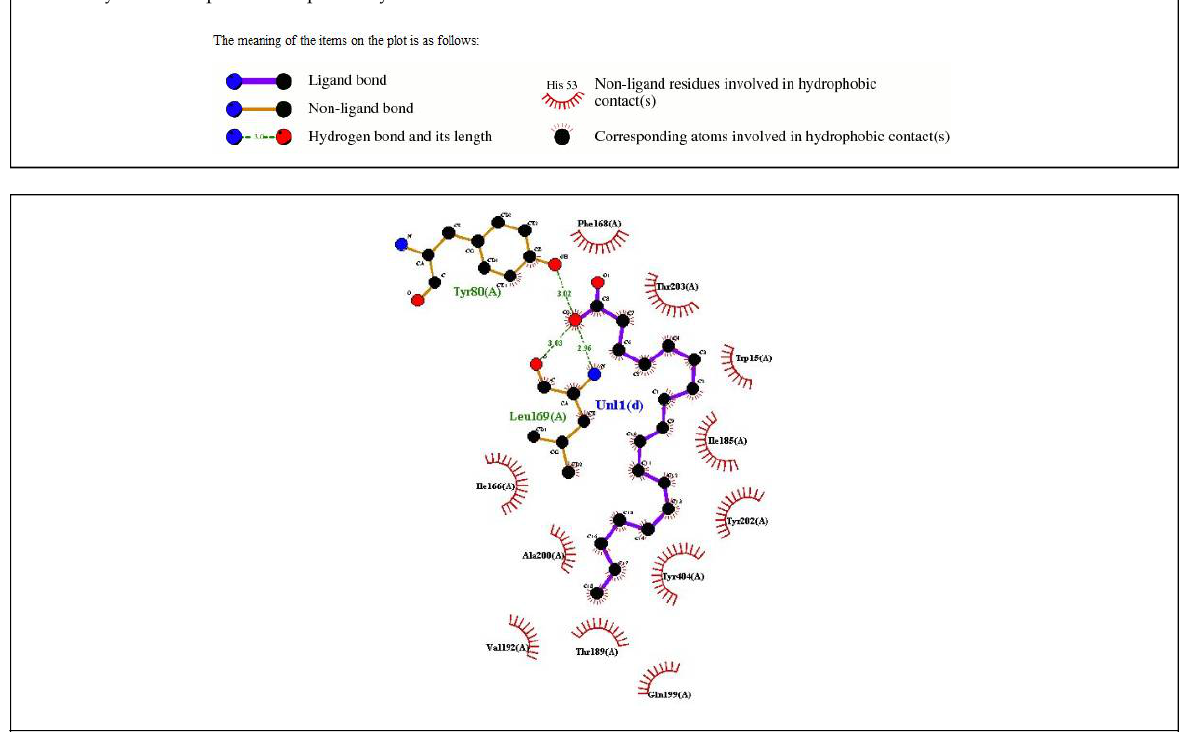
Figure 3: In UDP-glucose pyrophosphate (protein) and phytol (ligand) complex, the ligand form a single hydrogen bond (represented as green broken lines with bond length) with amino acid Asn163 of the Note: In N-myristolytransferase (protein) and 9,12-Octadecadienoic acid (Z,Z) (ligand) complex, the ligand form double and single hydrogen bonds (represented as green broken lines with bond length) with amino acid Leu169 and Try80 of the protein respectively.